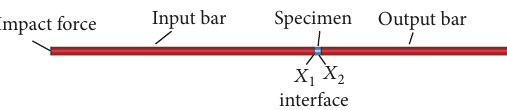
Figure 4: Modeling of the SHPB apparatus.